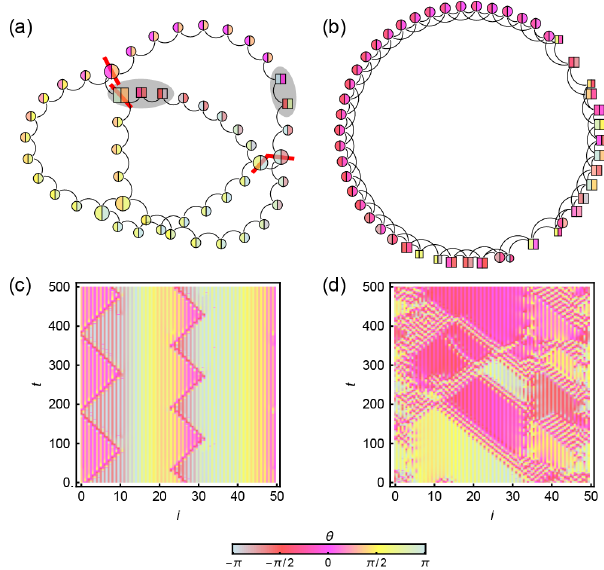
FIG. 11. Effects caused by network disorder in rings with [(a) and (c)] k ¼ 1 nearest neighbors perturbed by link addition and [(b) and (d)] k ¼ 2 nearest neighbors perturbed by link removal. The top panels show snapshots of the networks with the phases color coded on the oscillators, with squares showing instanta- neously asynchronous oscillators, circles showing instantane- ously phase-locked oscillators, and the node size reflecting the degree. The bottom panels show the corresponding time evolu- tion of the phases. In (a), the asynchronous domains (highlighted by the shaded ellipses) are confined within the domains marked by red